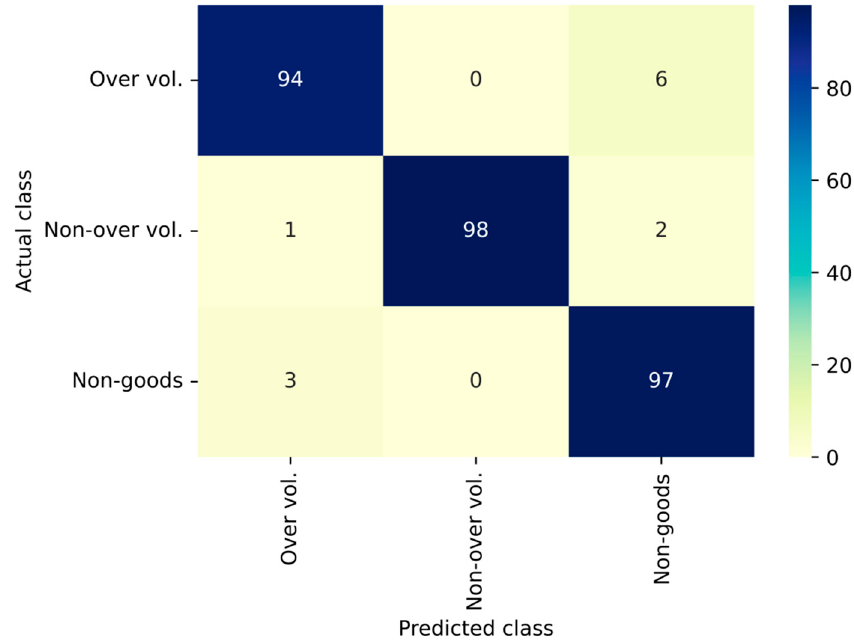
Figure 7. The 3 × 3 confusion matrix for the best model.